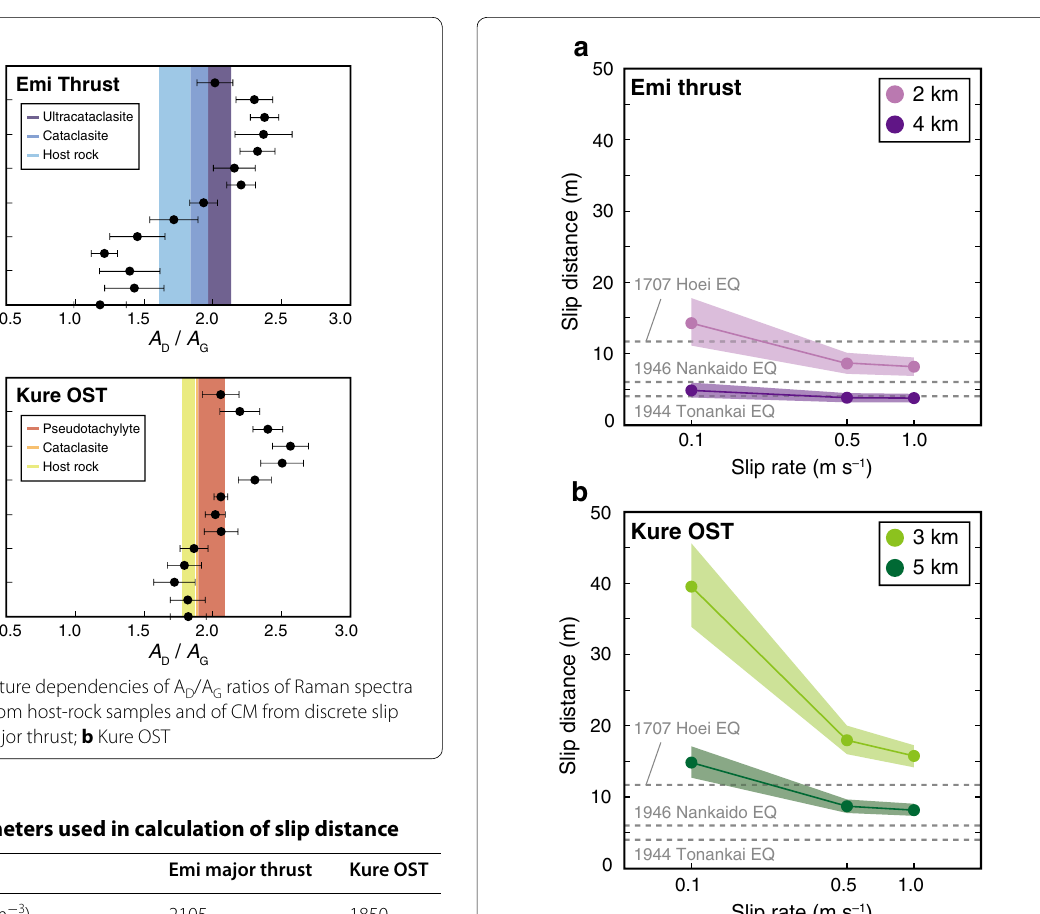
Table 1 Parameters used in calculation of slip distance Parameter